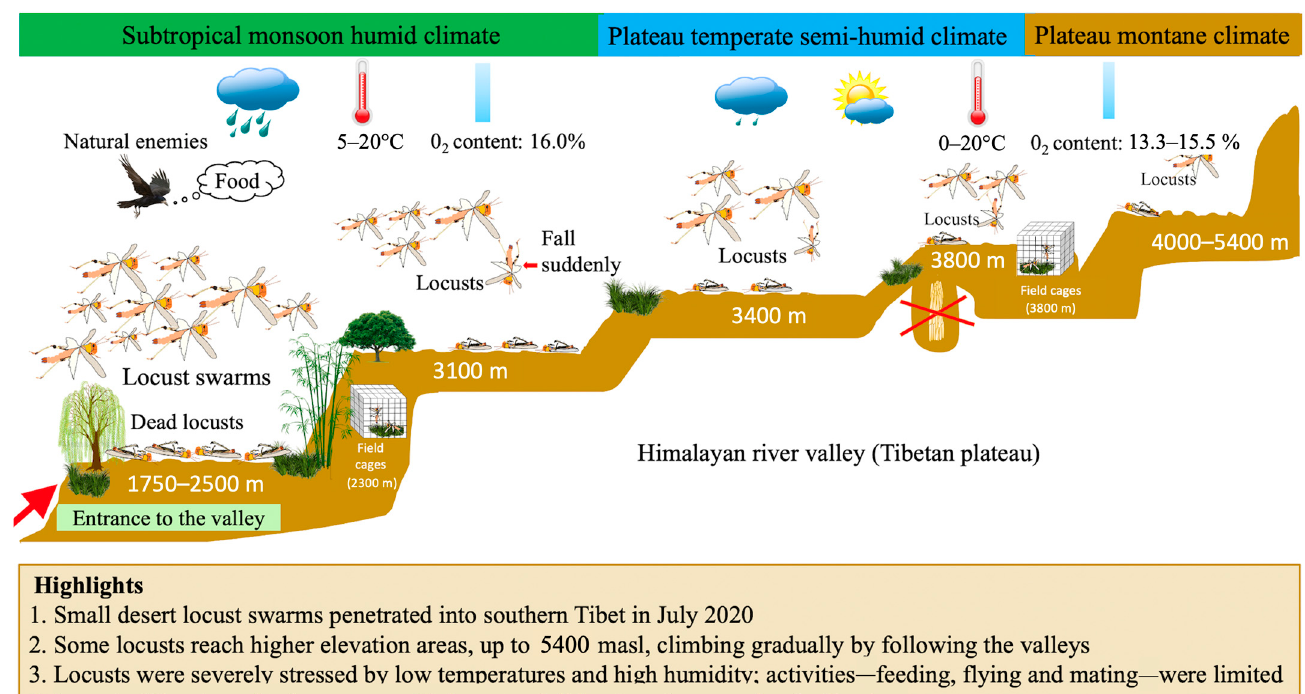
Figure A1. Desert locust invasion pathways, survival, and reproduction on the Tibetan Plateau in China.